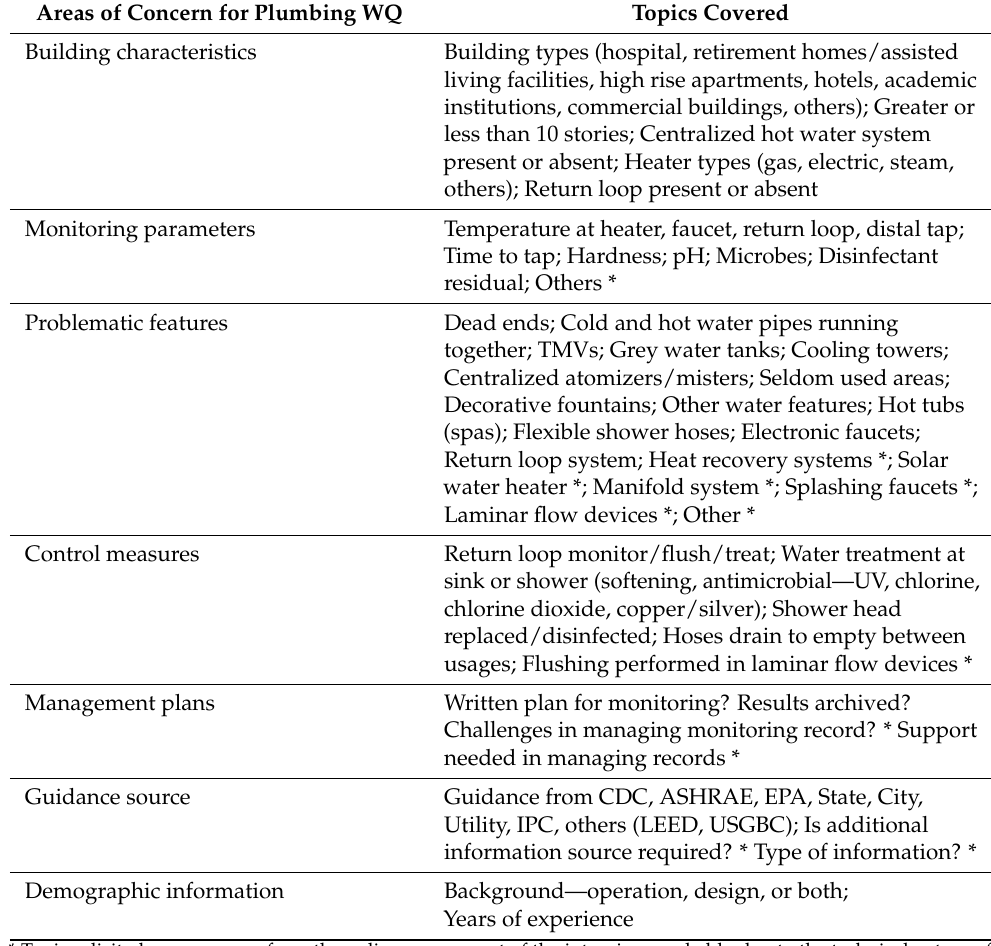
Table 1. Major concerns regarding water quality management in buildings, and topics covered within each of them, in the interview